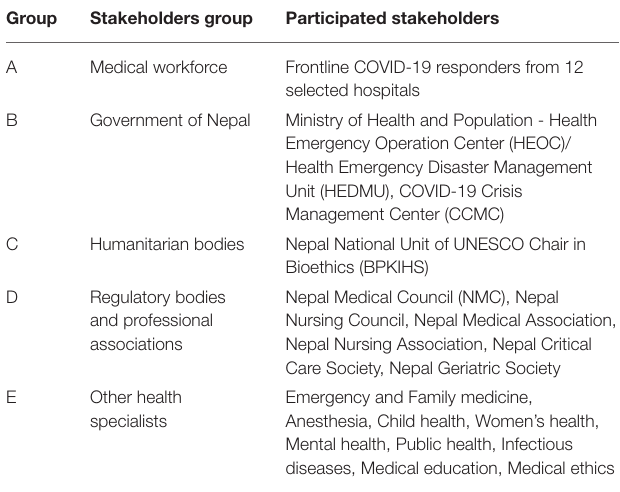
TABLE 1 | List of stakeholders who participated in the